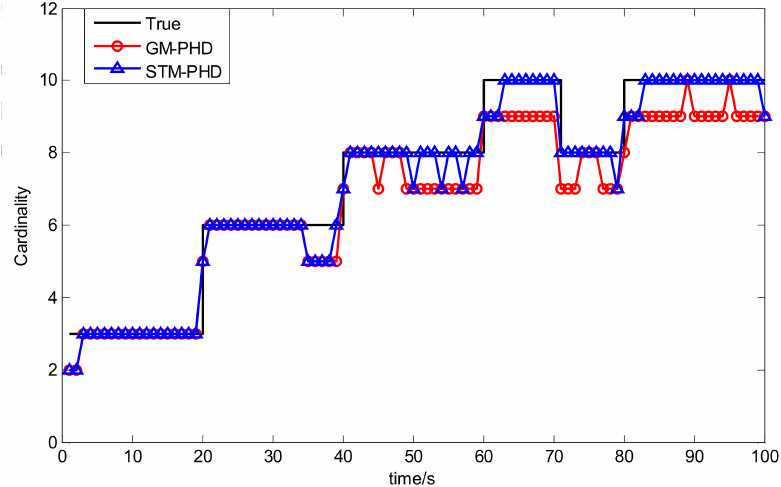
Figure 4. Comparison of cardinality estimation of two filters with fixed clutter rate ( λ c =